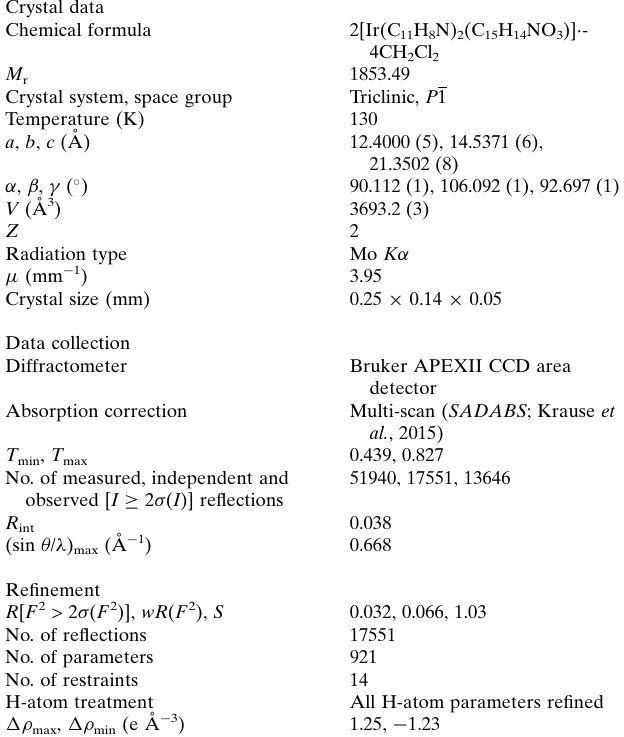
Crystal data Chemical